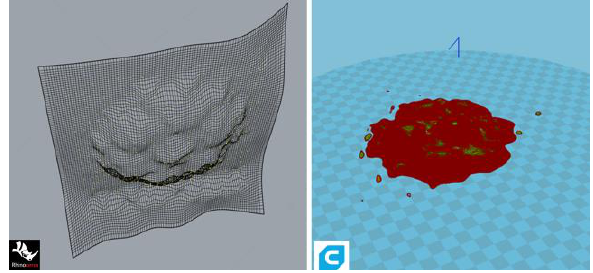
Figure 13. Creating mesh into Rhino and check into CURA.